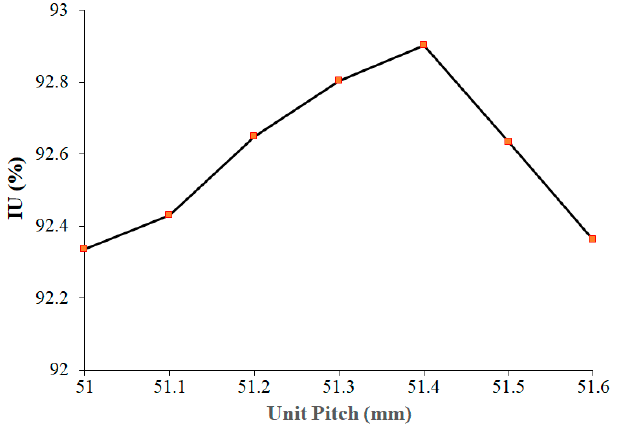
Figure 5. Variation in the IU with LPL unit pitch.